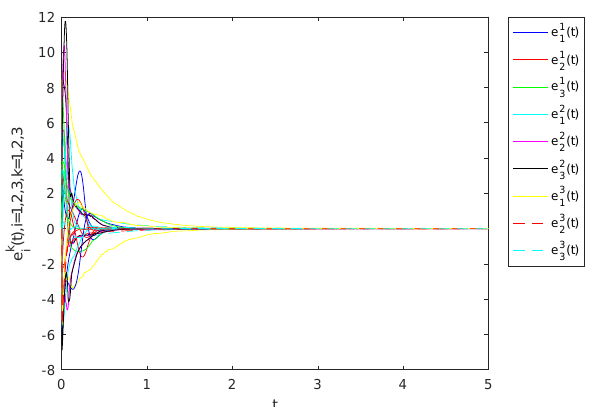
Figure 23. Quantized controller ¯ u